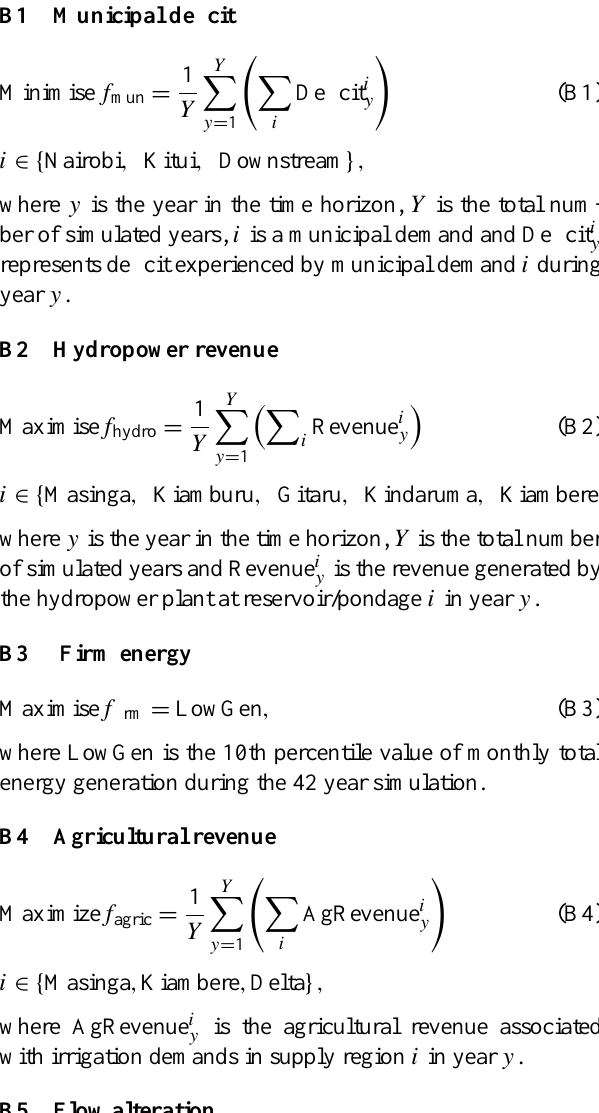
Table A1. Non-hydropower demands by month on reservoirs in the Seven Forks project (in m 3 s − 1 ) (Kiptala, 2008) applied to both cases.